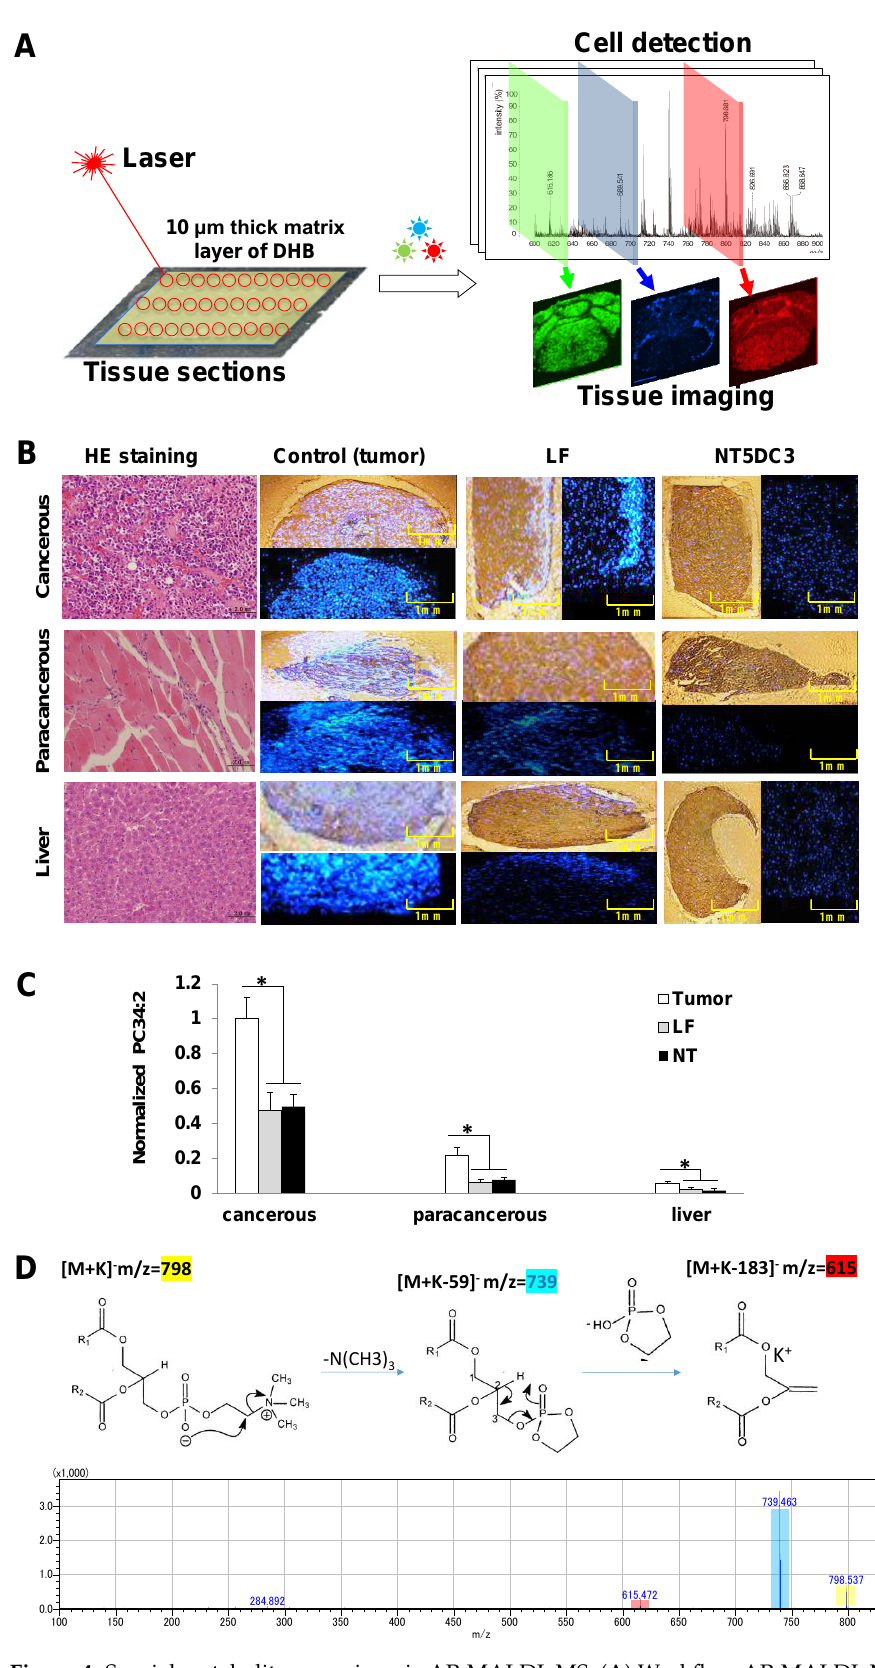
Figure 4. Special metabolite screening via AP-MALDI–MS. ( A ) Workflow AP-MALDI–MS imaging. ( B ) HE staining results (40 × ) and MSI of the cancerous, paracancerous, and liver tissues in